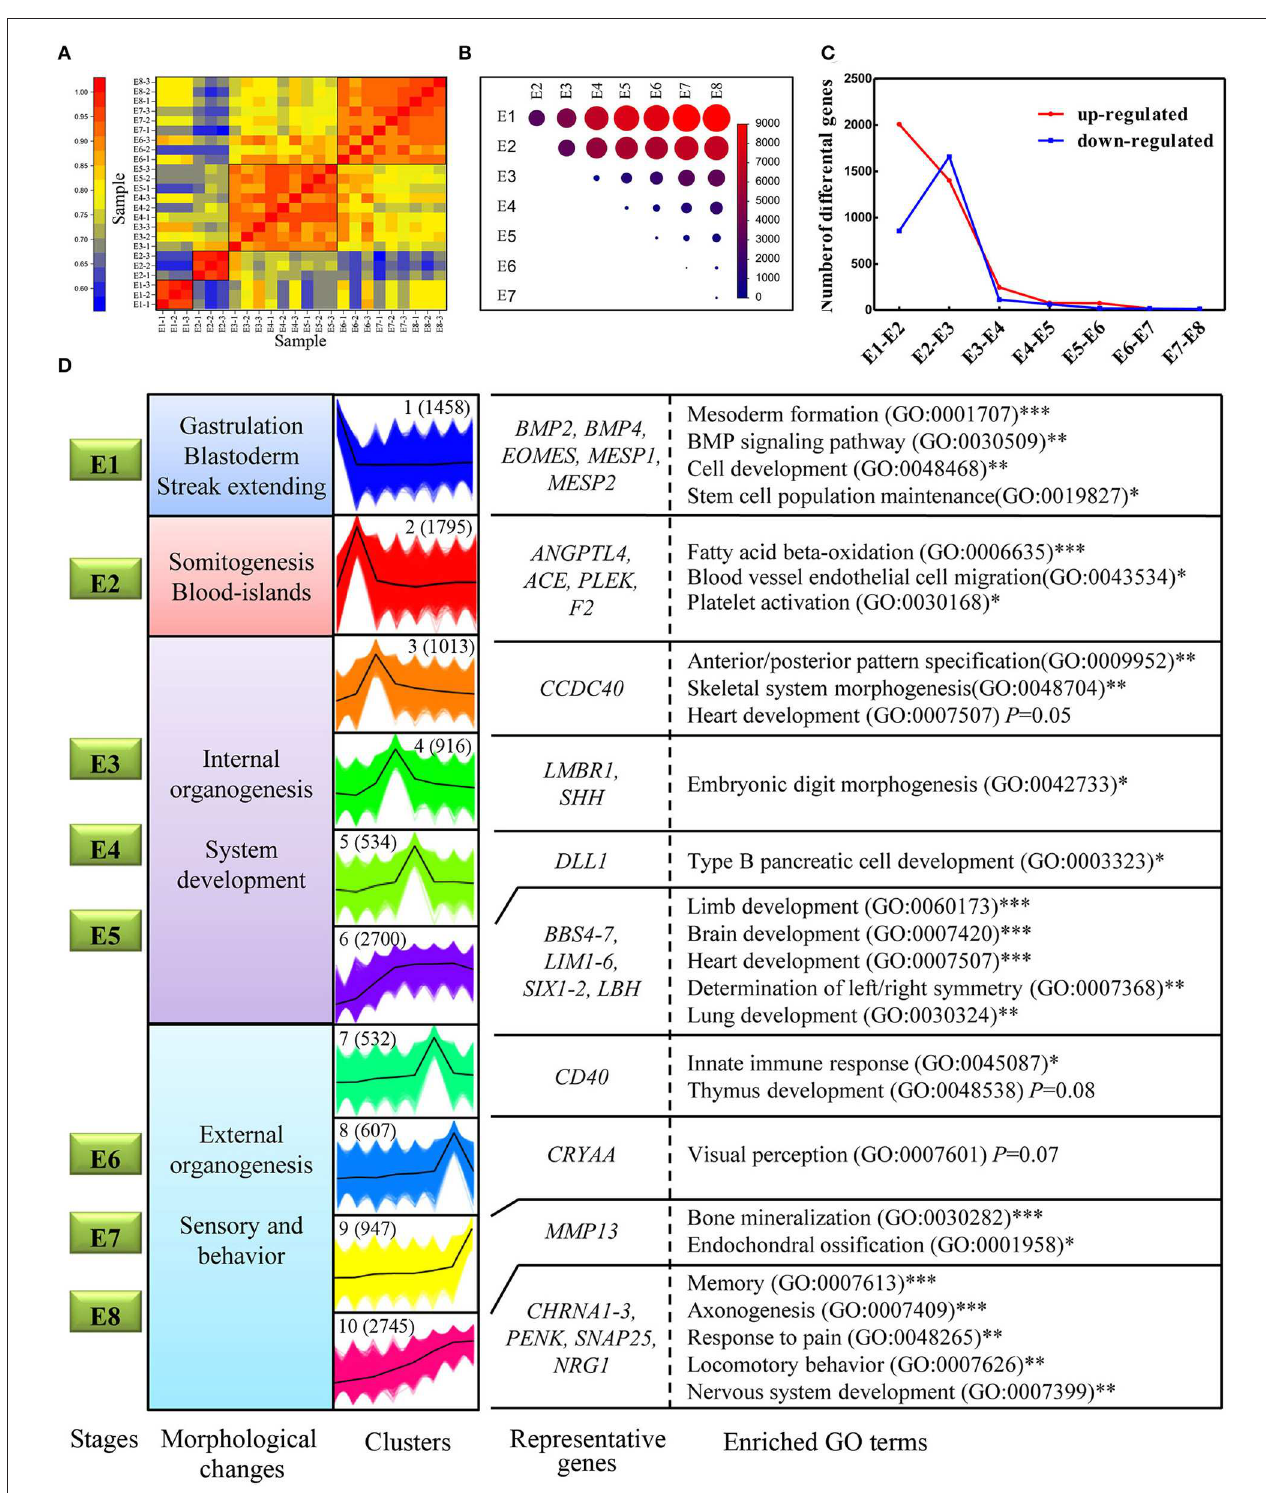
FIGURE 6 | Transcriptome dynamics during chicken embryo development. (A) Heatmap of Pearson’s correlation coefficient between transcriptomes from the eight different embryonic stages. The four clustered stages were marked with black boxes. (B) Visualization of the number of differentially expressed genes between each pair of stages. The size of the circles represents the number of differentially expressed genes. Genes with log2fold change > 1 and FDR < 0.01 were considered as